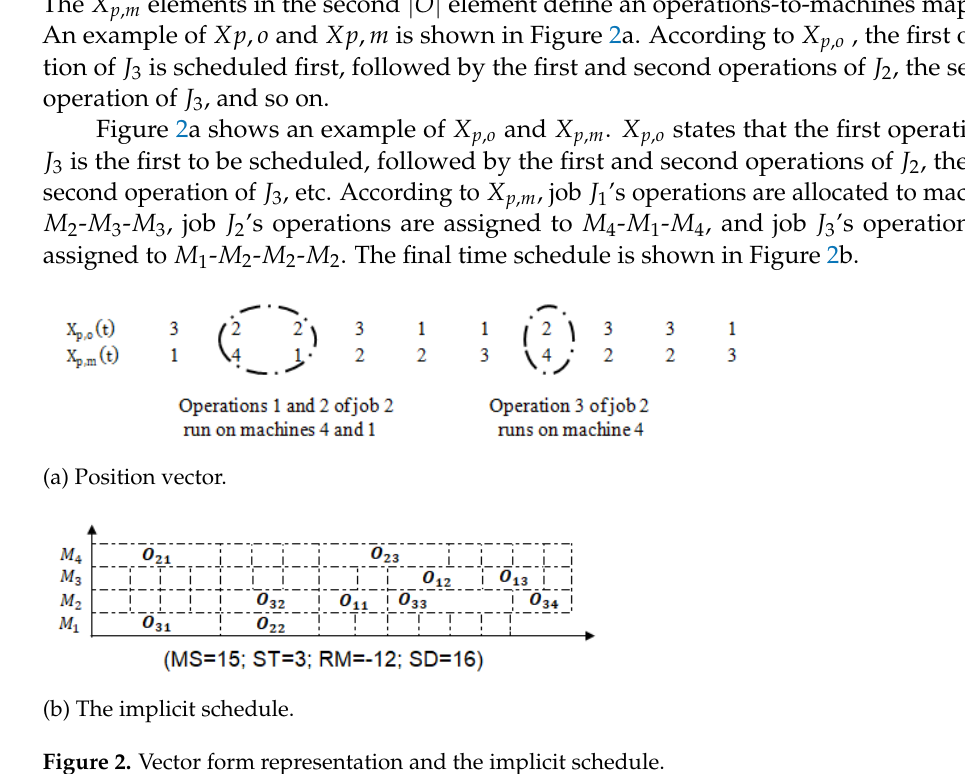
Figure 2. Vector form representation and the implicit